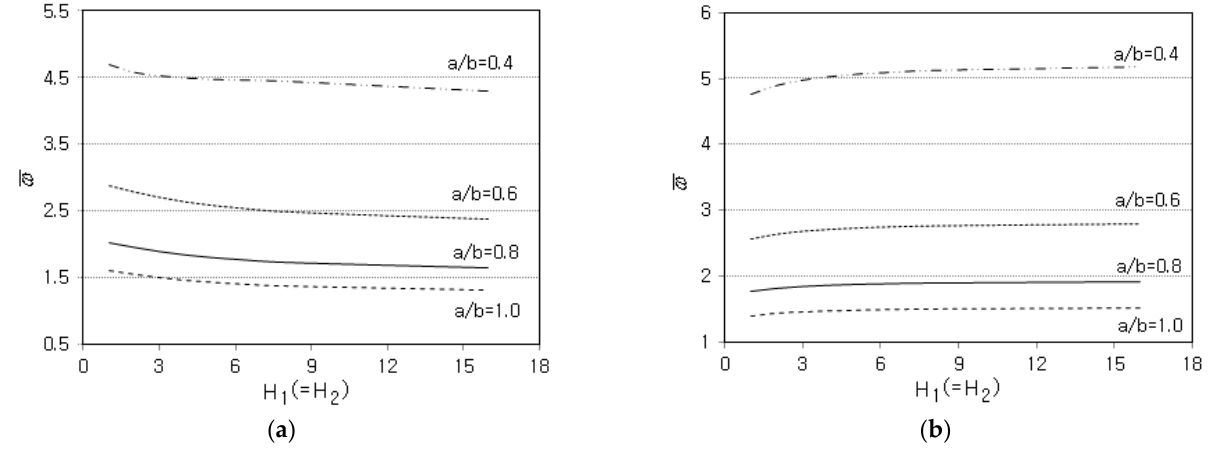
Figure 10. Effect of aspect ratio, a / b , on the calibrated fundamental frequency, ω for: ( a ) softcore cases; ( b ) hardcore cases.